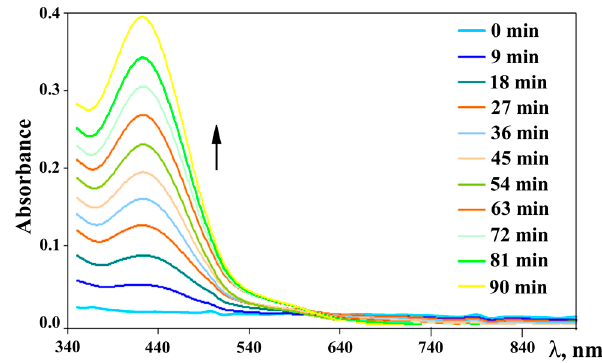
Figure 4. The changes in the absorption spectrum of thioether L 1 during the electrolysis time (90 min) at a controlled potential 1.2 V (MeCN, Ar, C = 0.5 mM, 0.15 M TBAP). The absorption band in the visible spectral range corresponds to a π - π * transition, which is a characteristic for compounds containing a quinonoid fragment like 3.5-di- tert -butyl- o -benzoquinone [81]. The CV of L 1 after electrolysis in the cathodic region contains a quasi-reversible peak at E 1/2 = − 0.58 V (Figure S12 of ESI). This peak is assigned to the reduction of electrogenerated o -benzoquinone to o -benzosemiquinone. The second oxidation peak on CVs of catechols L 1 , L 3 may be assigned to the oxidation of the phenolic group. In acetonitrile, for compounds L 1 and L 3 , the shift of the second oxidation potential to the cathode region occurs as compared to the oxidation of the well-known phenolic antioxidant (ionol)—2,6-di- tert - butyl-4-methylphenol 1.47 V (CH 3 CN). In dichloromethane, the oxidation potentials of L 1 and L 3 are close to the value for this phenolic compound (1.48 V). The presence of the thioether group causes the appearance of the third redox wave at high anodic potentials. For L 1 and L 3 in acetonitrile, the values Е ox3 are in good agreement with the data on the oxidation of catechol thioethers: the electrooxidation of the thioether group occurs in the potential range from 1.59 to 1.67 V. On the CVs of L 1 , L 3 in dichloromethane, two oxidation waves only are observed and they are shifted to the anodic region by 0.15 and 0.19 V in comparison with the data in MeCN. Obviously, the third anode process occurs at the higher anodic potential restricted by the electrochemical oxidation of the solvent. The CV of L 2 in dichloromethane solution has three oxidation peaks like the CVs of L 1 and L 3 in acetonitrile (Figure 5).